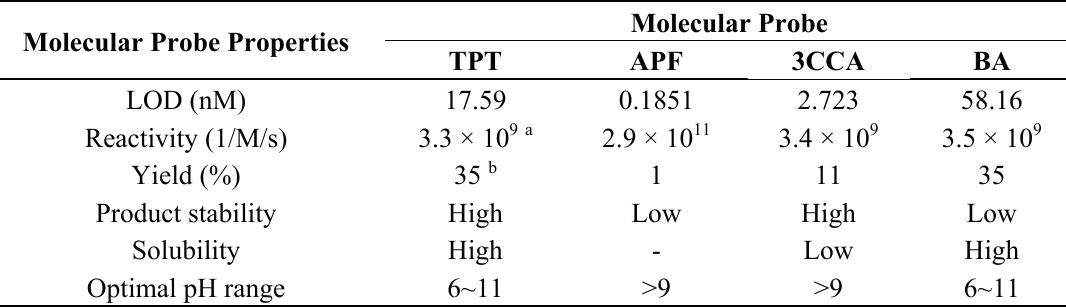
Table 2. Summary of molecular probe